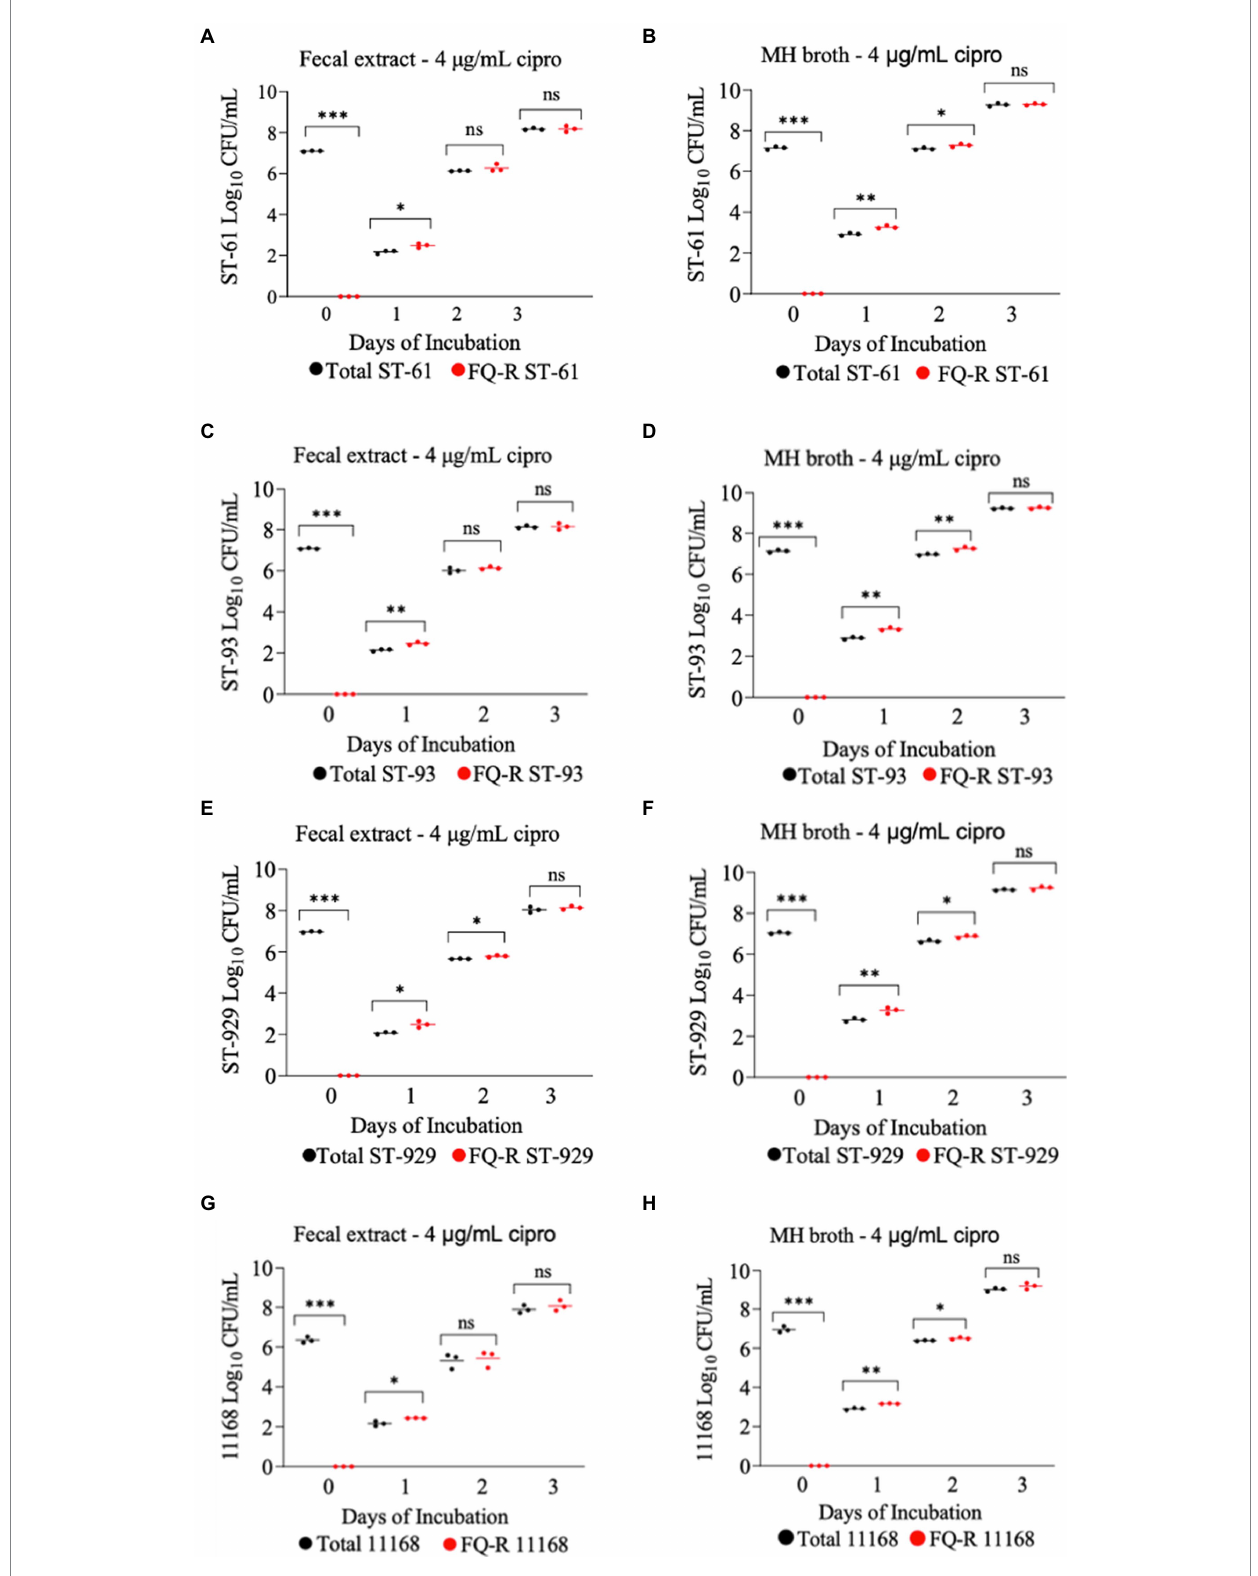
FIGURE 4 Development of FQ-resistant Campylobacter jejuni mutants (shown as red dots) from FQ-susceptible strains (ST-61, ST-93, ST-929, and NCTC 11168) grown in bovine fecal extract (A,C,E,G) and MH broth (B,D,F,H) supplemented with 4 μ g/mL of ciprofloxacin. The initial bacterial cell density (day 0) of each inoculum was 10 7 CFU/mL. Black dots denote total (susceptible + resistant) colonies. Each dot represents the log 10 CFU/mL of each strain at a given time point (horizontal bars represent the mean log 10 CFU/mL of three replicates). The number of bacterial colonies was measured on days 0, 1, 2, and 3 of incubation. The detection limit of the culture was ~ 10 CFU/mL medium. The experiment was repeated twice, and the results of one representative experiment are